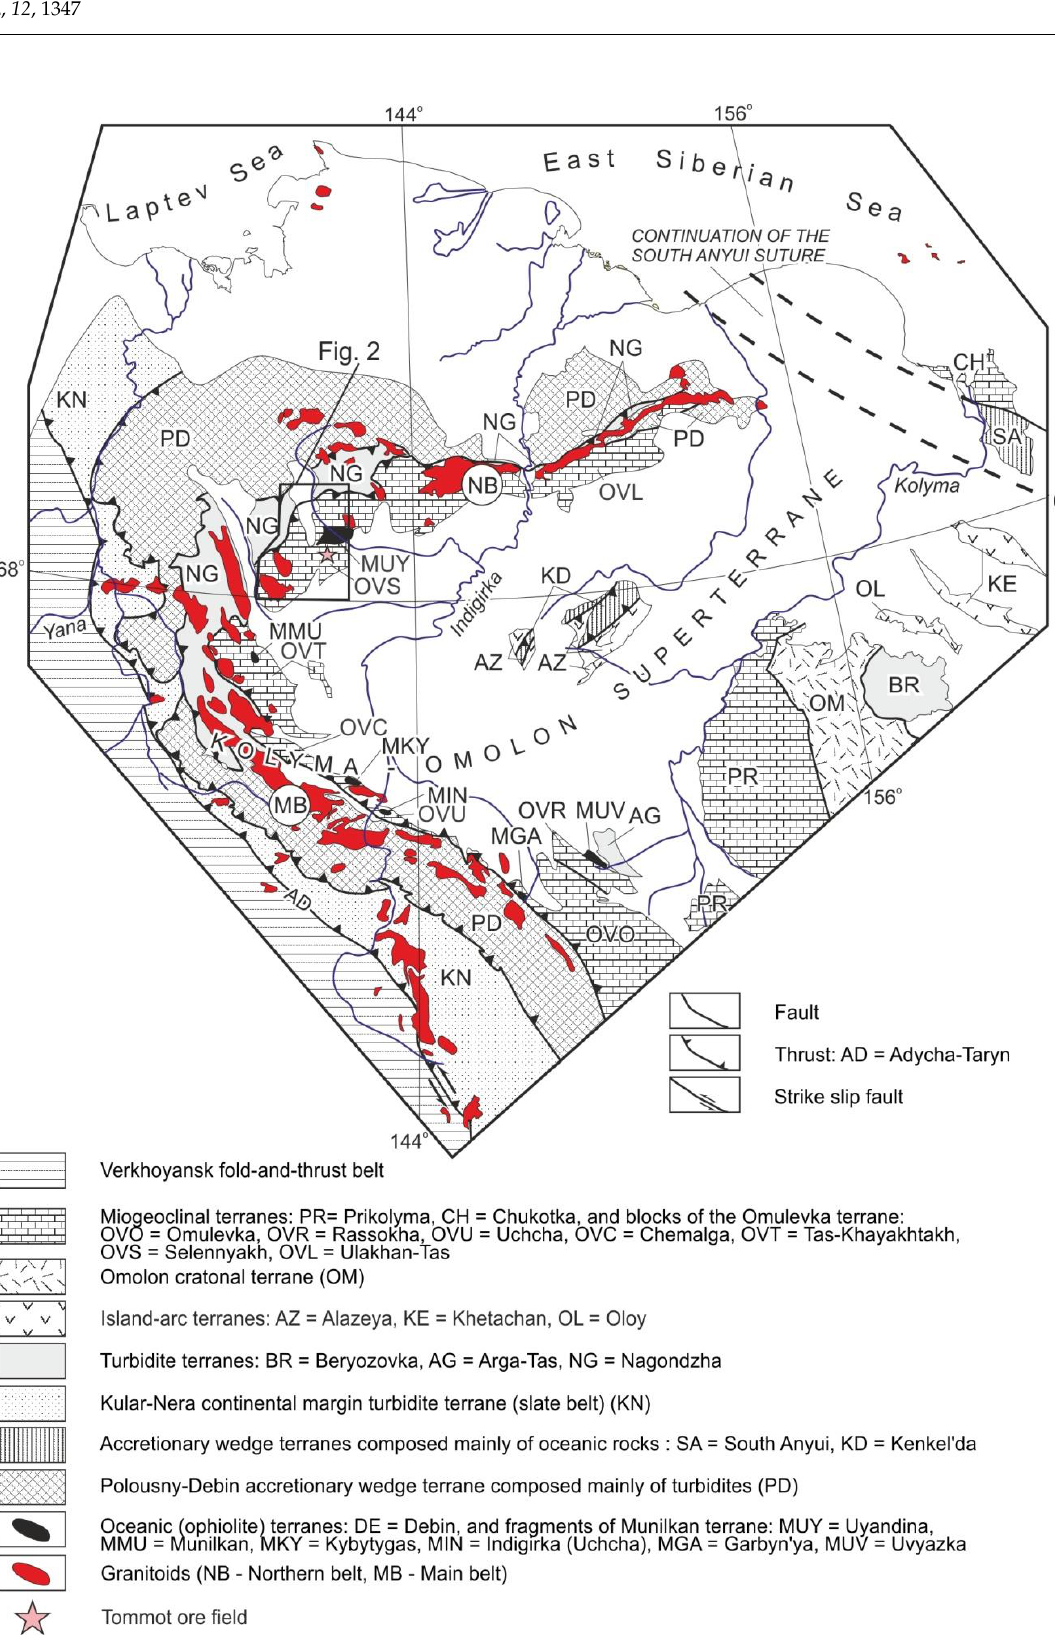
Figure 1. Tectonic map of the northeastern Verkhoyansk – Kolyma orogenic belt [modified 23].